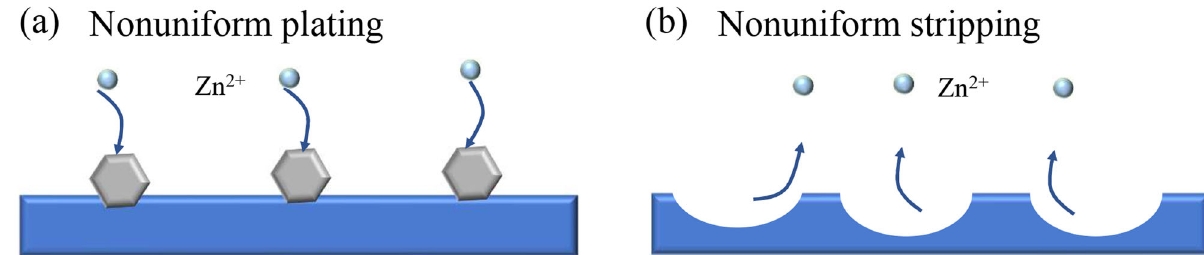
Fig. 1 Schematic illustrating the difference between plating and stripping. a Schematic of the nonuniform plating process. b Schematic of the nonuniform stripping process. The pale blue spheres represent Zn ions, the solid blue substrate represents the Zn metal electrode, and the grey hexagons represent the deposited Zn lamellae. Different morphologies can be obtained due to the different initial processes (stripping or plating).